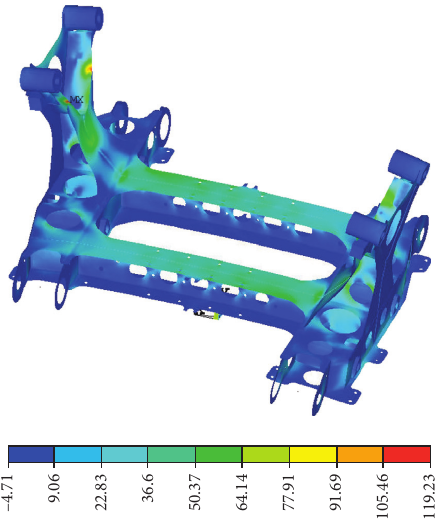
Figure 6: FPS plot of motor